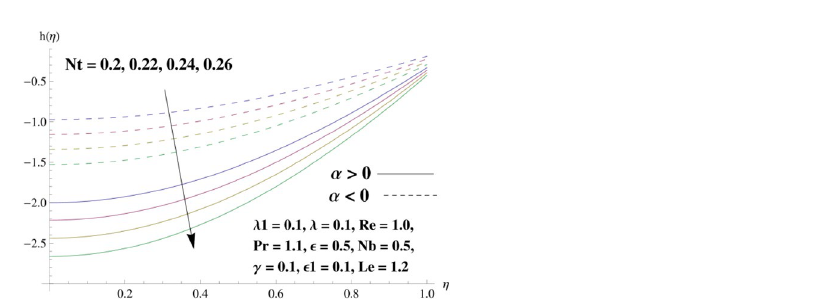
Figure 15. Behavior of h (η) against N t